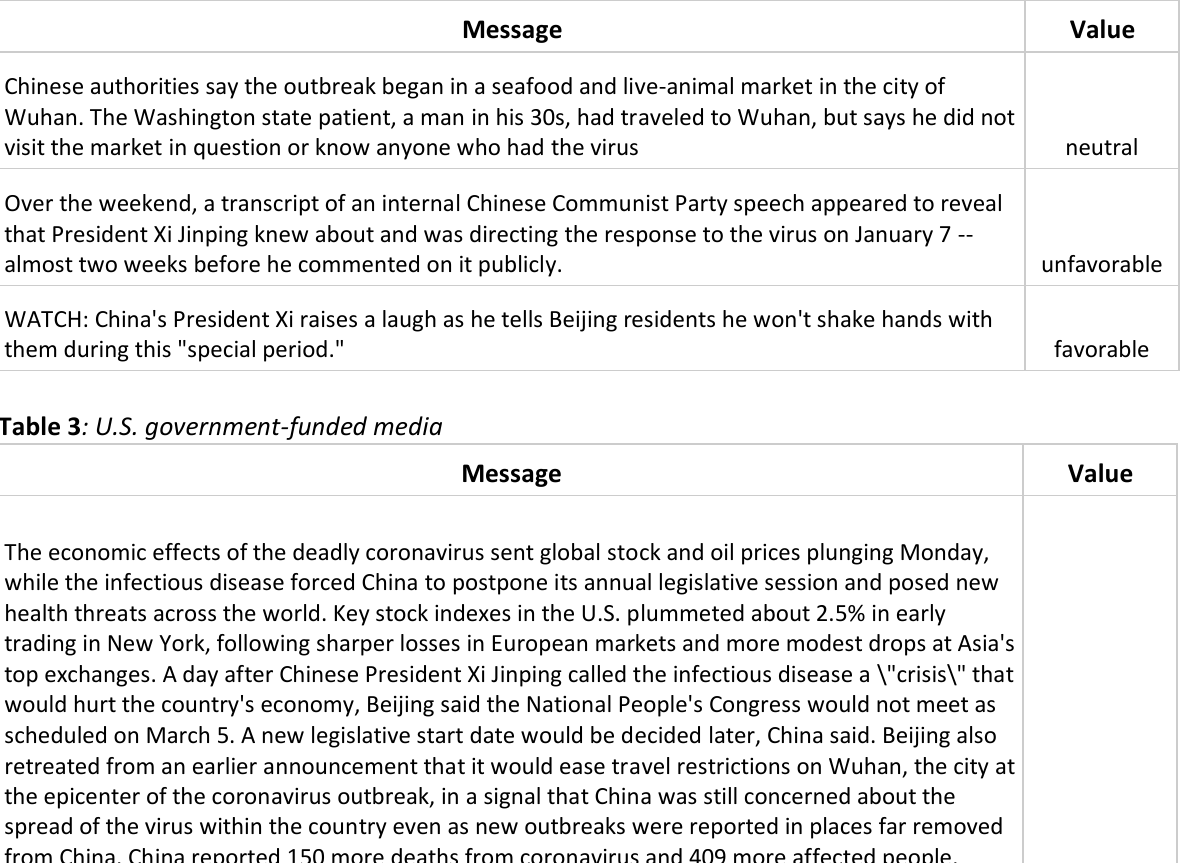
Table 2 : U.S. mainstream media